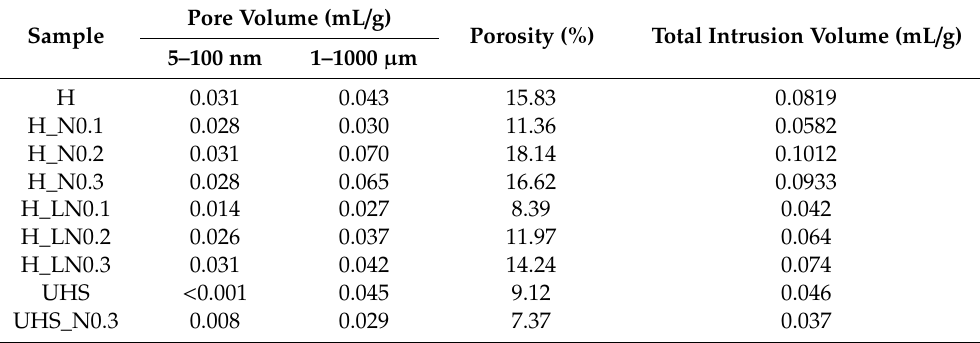
Table 5. Pore characteristics of HPFRCC as measured by